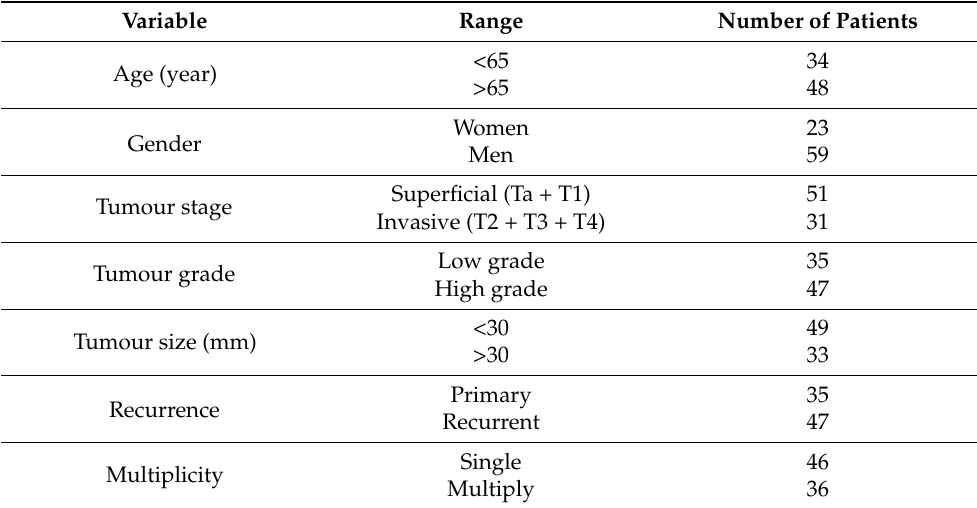
Table 1. Demographic and clinicopathological characteristics of